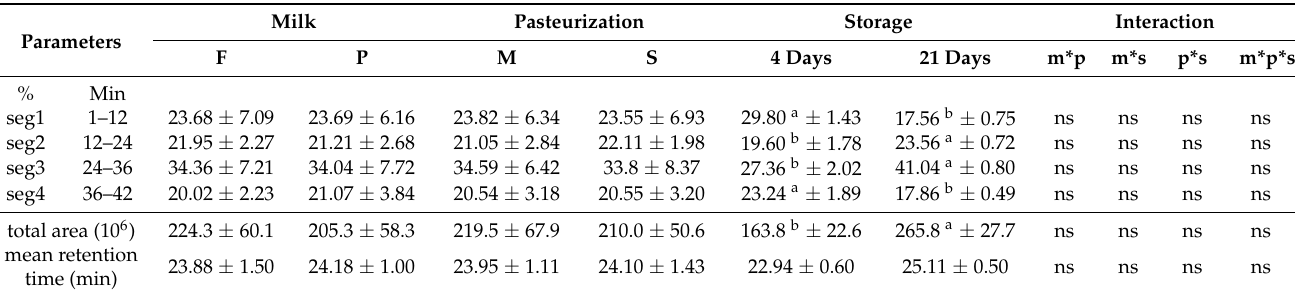
Data are expressed as least square means ± standard deviation. Means followed by a different superscript letter in the row for each factor are significantly different ( p < 0.05). ns: not significant. Interactions: m*p (milk*pasteurization), m*s (milk*storage), p*s (pasteurization*storage), and m*p*s